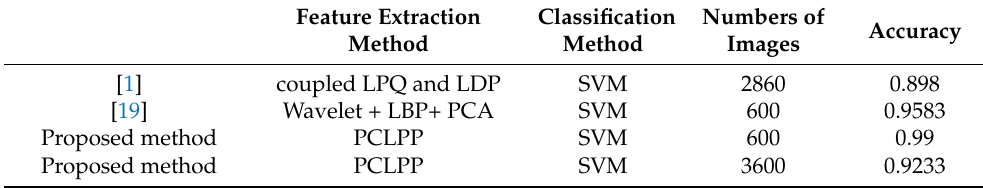
Table 2. Identification rate by different methods in